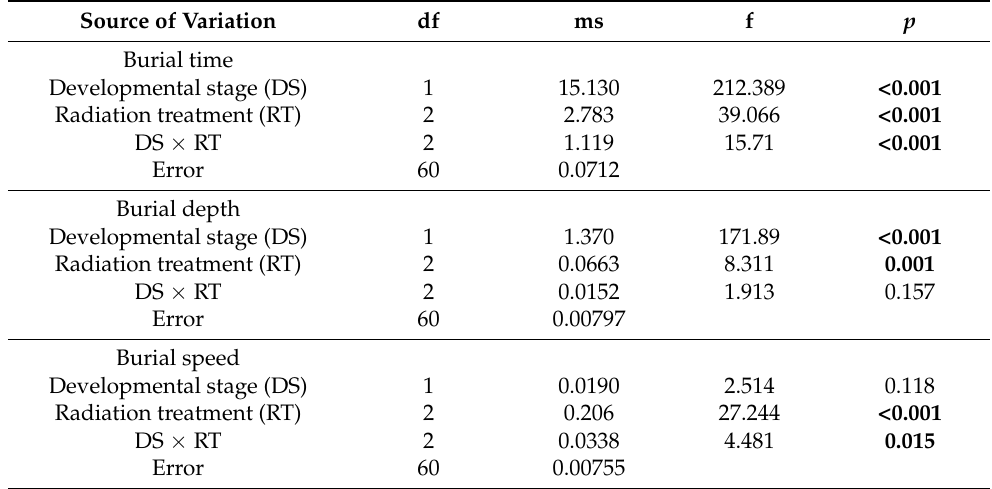
Table 1. Two-way ANOVA for comparison of burial parameters (time, depth and speed) in different developmental stages (adults and juveniles) of A. hermaphroditica exposed to different levels of experimental radiation P (PAR), PA (PAR + UVA) and PAB (PAR + UVA + UVB). Bold numbers indicate significant difference ( p < 0.05). Source of Variation df ms f p Burial time Developmental stage (DS) 1 15.130 212.389 <0.001 Radiation treatment (RT) 2 2.783 39.066 <0.001 DS × RT 2 1.119 15.71 <0.001 Error 0.0712 Burial depth Developmental stage (DS) 1 1.370 171.89 <0.001 Radiation treatment